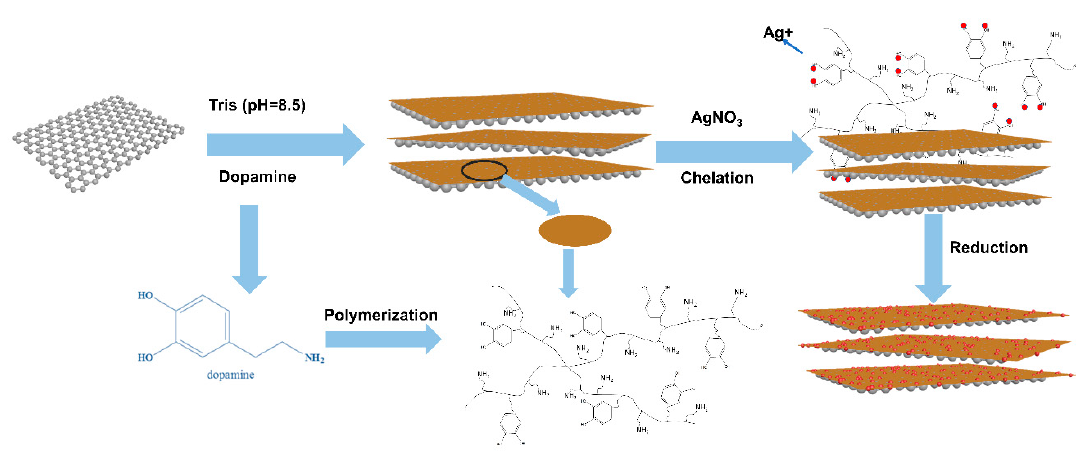
Figure 1. Schematic diagram of dopamine polymerization and reduction of GO and in situ deposition of Ag nanoparticles (AgNPs) on the surface of PDA-reducing graphene oxide (RGO).